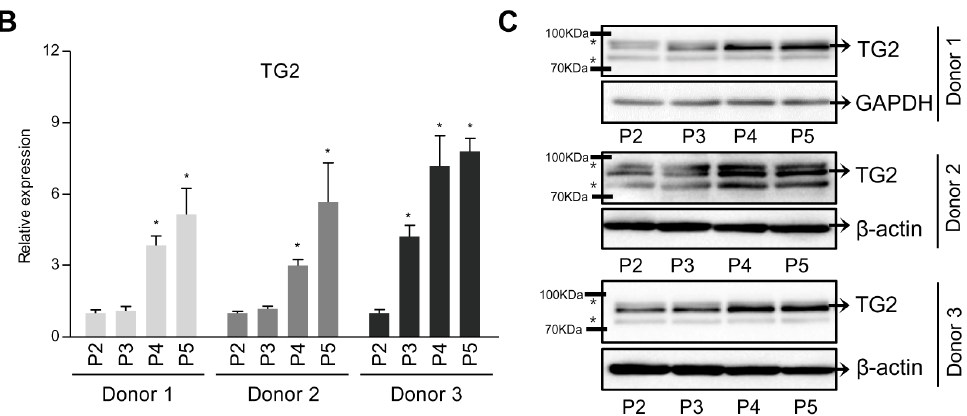
Figure 1. Induction of TG2 in dedifferentiated chondrocytes. Human articular chondrocytes were passed until passage 5 in normal growth medium. ( A ) COL2A1, SOX9 and ( B ) TG2 mRNA expression levels in human articular chondrocytes were measured by real-time qPCR. * p < 0.05. n = 3. ( C ) TG2 protein expression levels in human articular chondrocytes were detected by Western blotting using anti-TG2 polyclonal antibody. Asterisks denote other TGs. TG2 antibody cross-reacts with other transglutaminases. GAPDH and β -actin expressions were examined as a loading control.